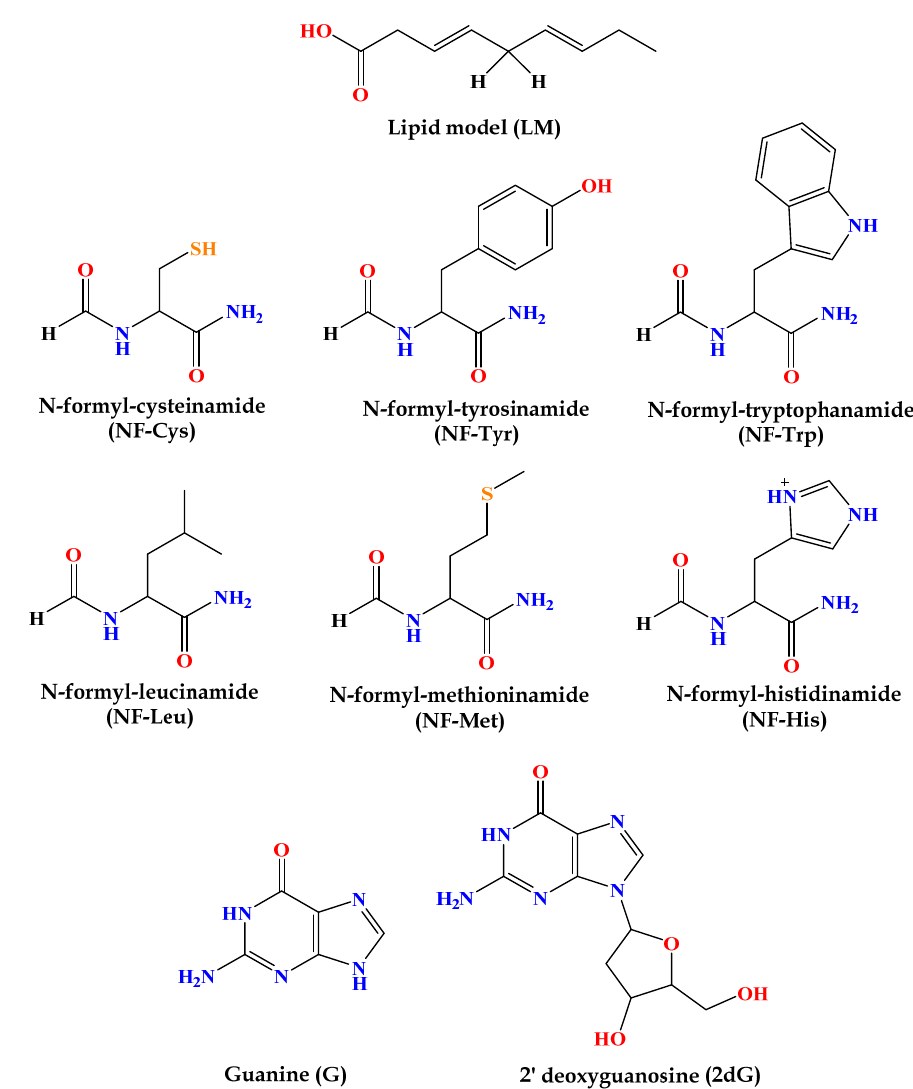
Figure 2. Structures of investigated molecular targets—constituents of important molecules: phospholipid bilayer, proteins, and nucleic acids.